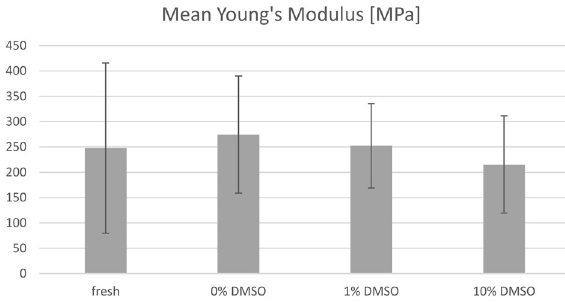
Figure 1. A correct version of the original Figure 7B.